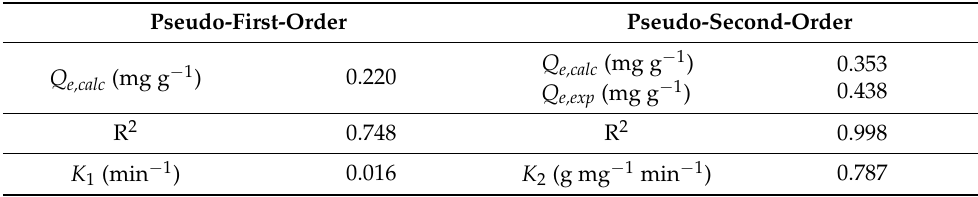
Figure 5. Adsorption kinetics: ( a ) pseudo-first-order model and ( b ) pseudo-second-order model for the removal of MB using Zeo-FPT. Table 3. Adsorption kinetics parameters calculated for the pseudo-first- and pseudo-second-order kinetics for the removal of MB using Zeo-FPT.